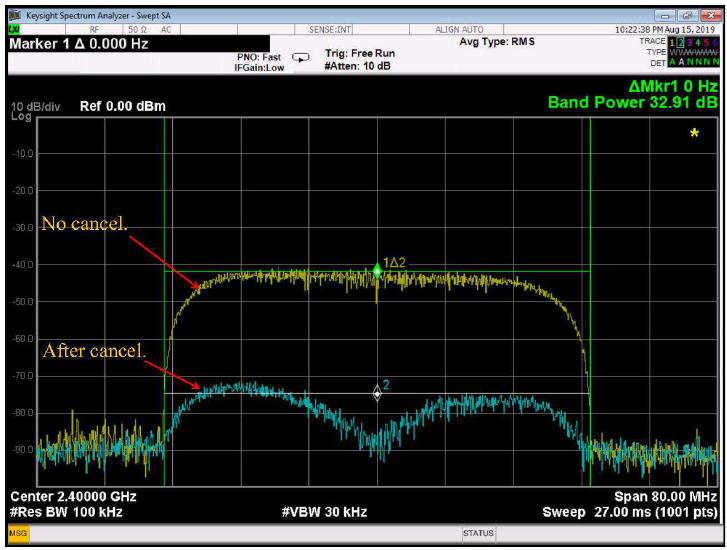
Figure 8. Measurement results for 50 MHz